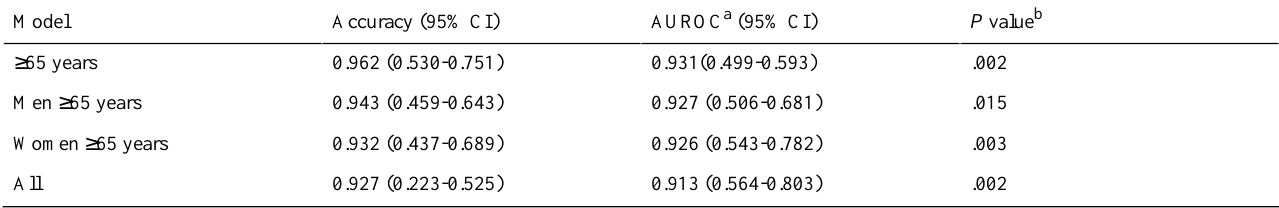
Table 3. Performance of the 4 DNN